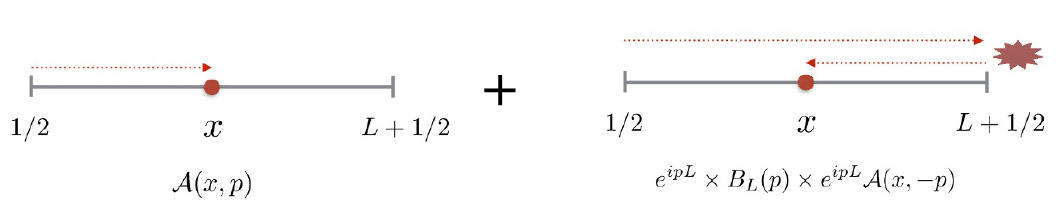
Figure 4 . The (cid:12)rst term describes the magnon moving on the open spin-chain from the point at the half-step shifted site (the left boundary) to the site x with the propagation factor the other hand, the second term means that the magnon (cid:12)rst moves to the right boundary with the factor e ipL . The boundary factor B L ( p ) appears when the magnon with momentum p re(cid:13)ects at the boundary site L + 1 . At the same time the magnon momentum has a sign (cid:13)ip as p 2 the magnon with p moves to the site x by the propagation factor e ipL (cid:0)